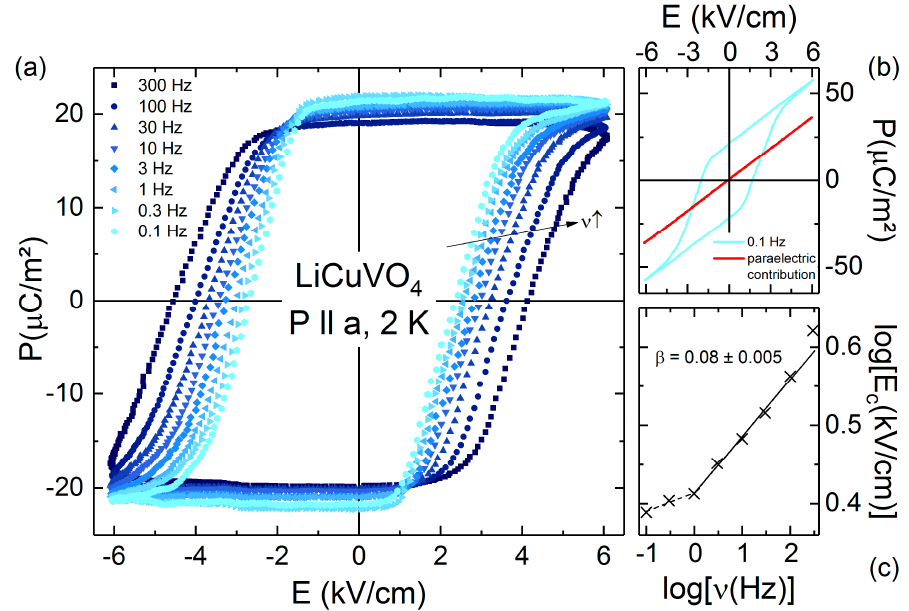
Figure 2. ( a ) Frequency dependent ferroelectric hysteresis loops of a LiCuVO 4 single crystal, with the dielectric background subtracted; ( b ) Raw data of hysteresis loop for 0.1 Hz and respective paraelectric contribution (red line). For ( a , b ) The polarization P was measured along the a direction at T = 2 K and in electric fields E up to 6 kV·cm − 1 ; ( c ) The inset shows a double-logarithmic representation of the coercive field E c vs. frequency ν . The line denotes a fit derived from the IO model resulting in a slope of β = 0.08 (see text).